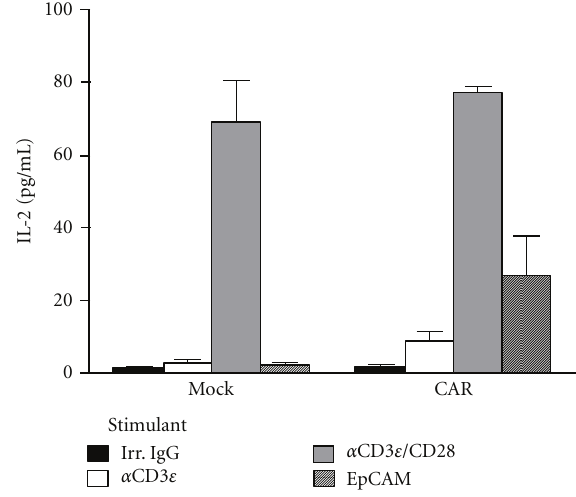
Figure 4: The phosphorylation status of the signaling proteins in CAR-expressing Jurkat cells. Cells were activated for 15min with the indicated stimulant, and the lysates were used for the DIAplex assay for IL-2 detection. Irrelevant mouse IgG was used as a negative control.